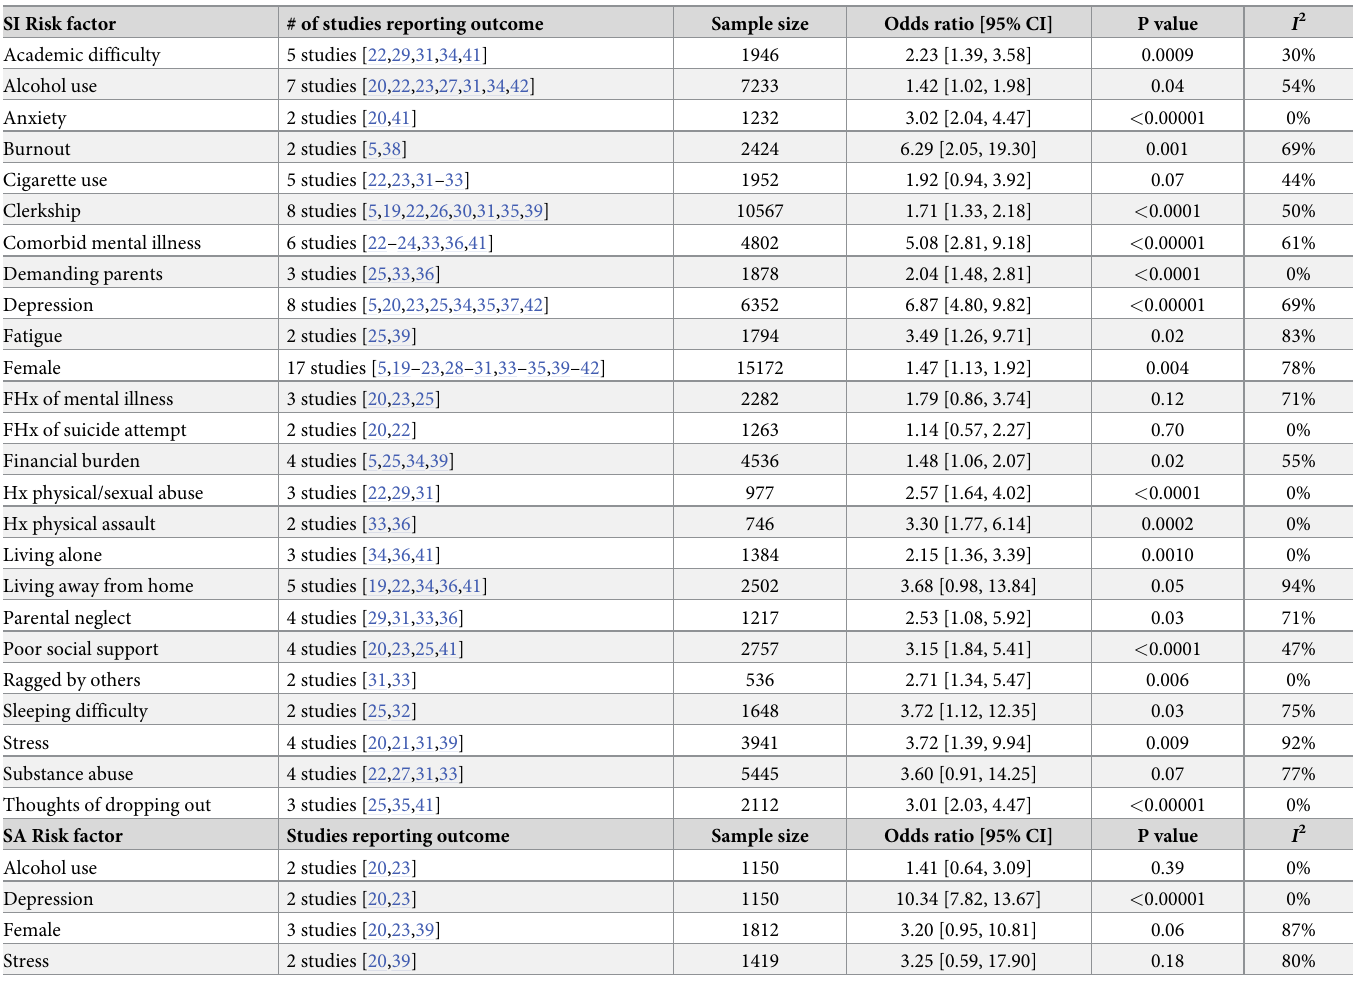
Table 2. Pooled effect estimates for risk factors associated with SI and SA among medical